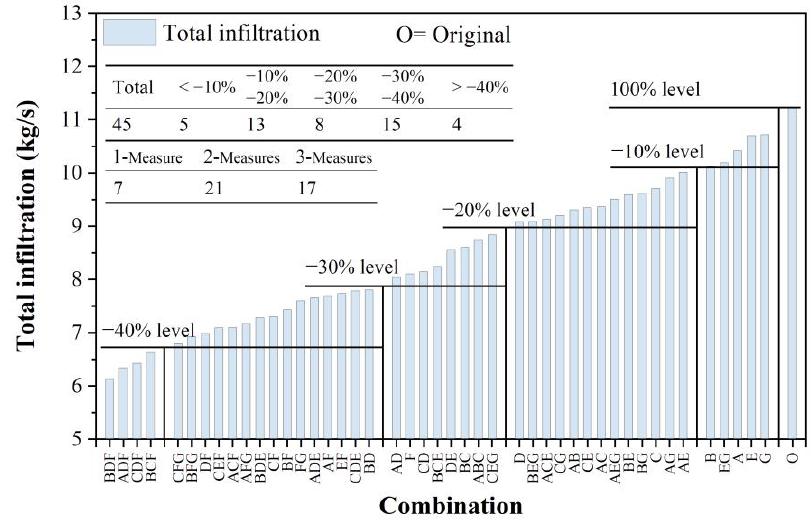
Figure 12. The candidate combinations for reducing total